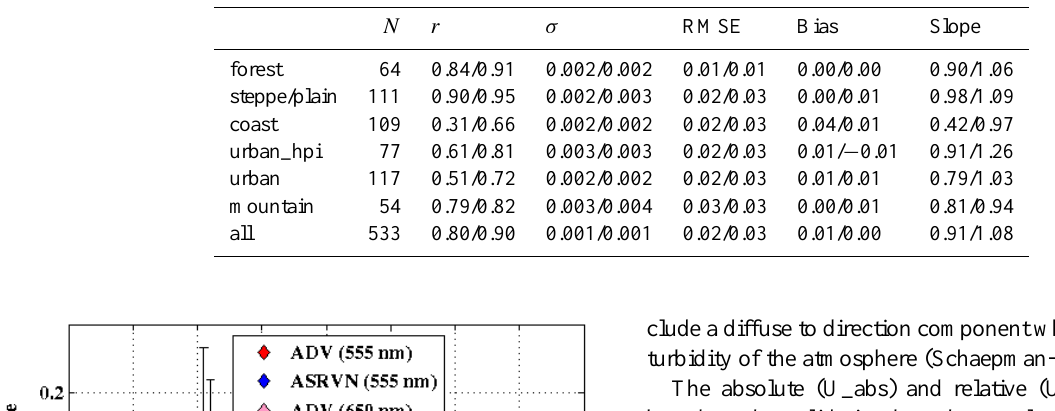
Figure 6. Scatterplots of ADV-retrieved surface reflectances versus surface reflectances derived from collocated ASRVN albedo matched to the AATSR solar zenith (SZ) angles for wavelengths of 555nm (left) and 659nm (right). Colors and symbols relate to different surface types; see legend. Table 1. Statistical metrics for the regression between the ADV and ASRVN surface reflectances at 555/659nm for different surface types and land use ( N – number of cases; r – correlation coefficient; σ – standard deviation; RMSE – root-mean-square error; and bias and slope – parameters for linear regression)